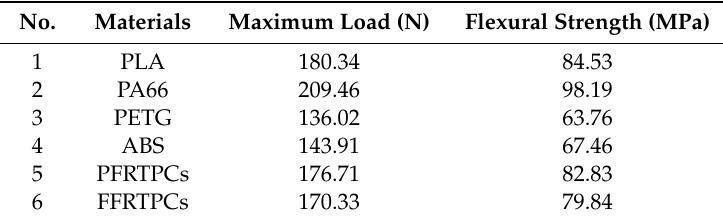
Table 4. Maximum load and flexural strength.